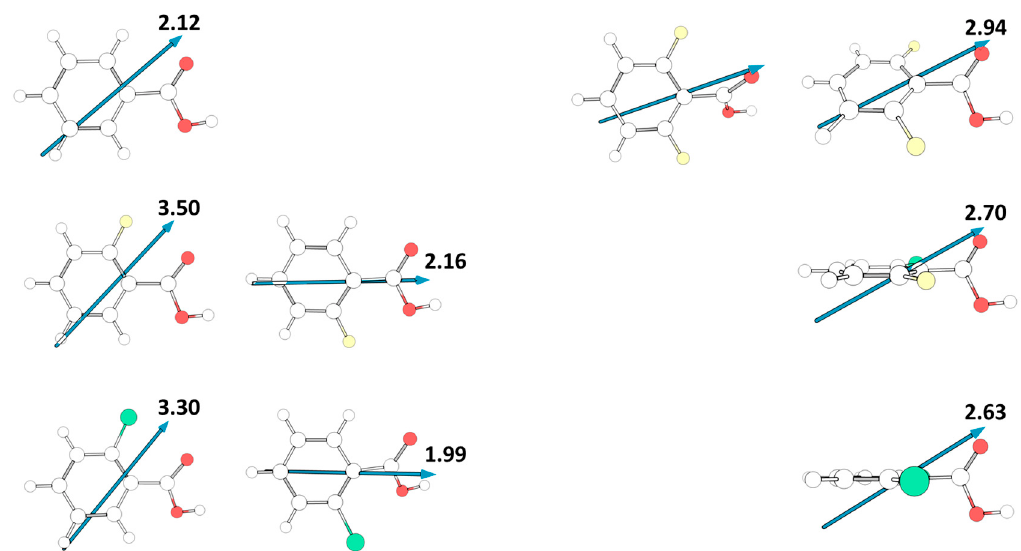
Figure 11. Calculated dipole moments (in Debyes; 1 Debye = ≈ 3.33564 × 10 − 30 C·m) for the studied molecules. For 2,6-difluorobenzoic acid, two representations are provided, one with the aromatic ring in the plane, and the other with the carboxylic acid substituent in the plane. In the case of the mono-substituted compounds (2FBA, 2CBA) the two cis conformers are shown.